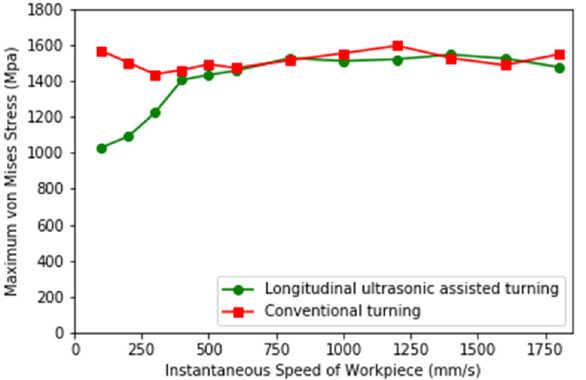
Figure 12. Maximum Mises stress of LUAT and CT.